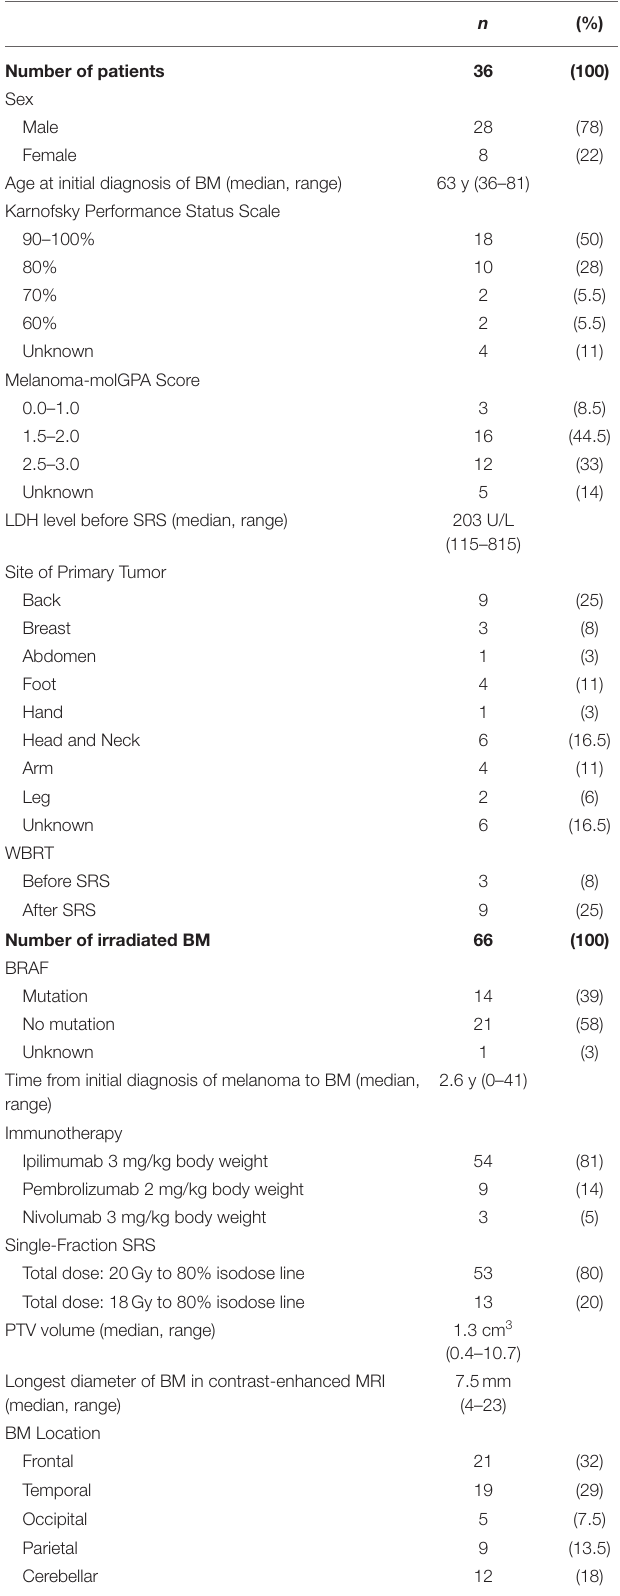
TABLE 1 | Baseline